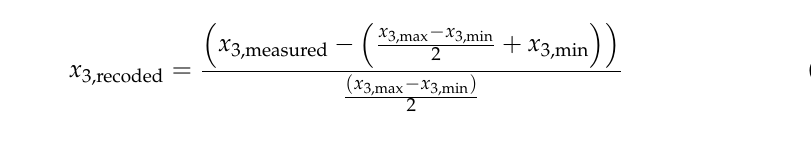
Table 2. Box–Behnken experimental design with three independent